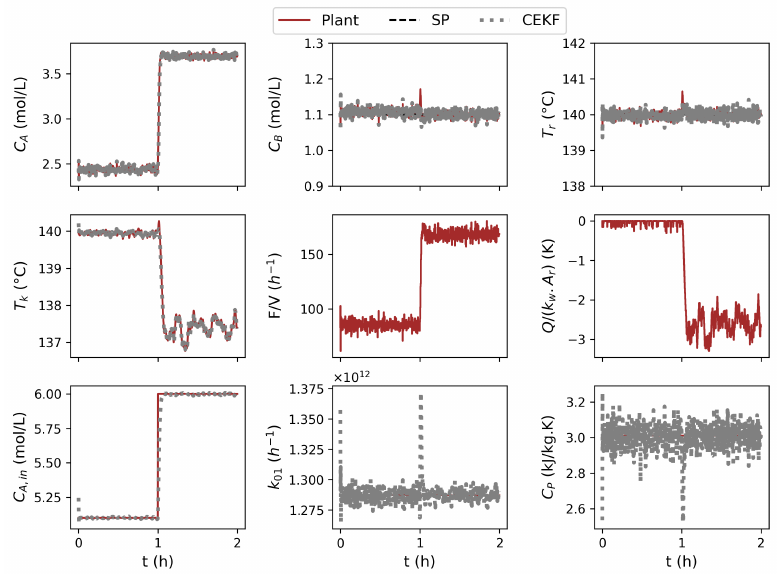
Figure 10. Results for Combination 8 for maintaining the set-points of 140 ◦ C and 1.1 mol/L, as well as a change in C A , in